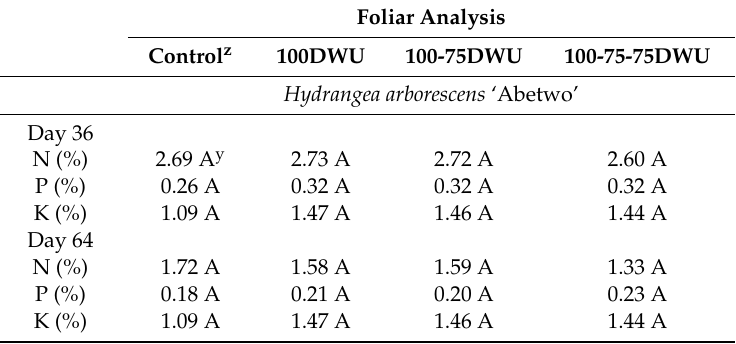
Table 6. Foliar analysis (% dry wt.) sampled on days 36 and 64 of six taxa grown in 10.2 L containers and subject to four irrigation treatments from 23 June (Day 1) to 31 October 2010 (Day 131). Control